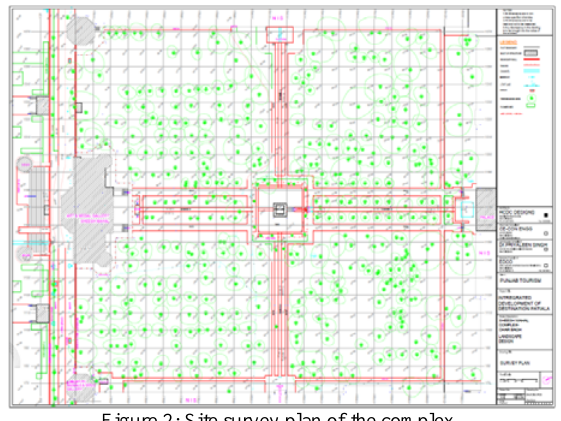
Figure 2: Site survey plan of the